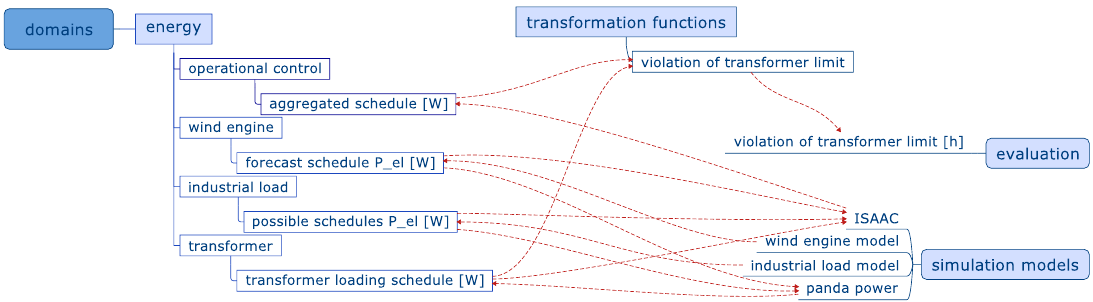
Figure 5. Example of the high-level simulation planning information